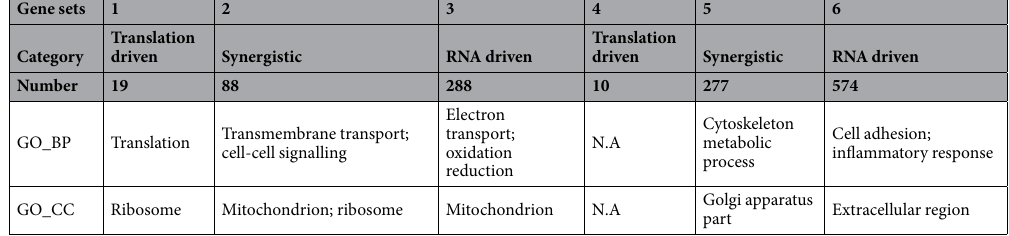
Table 3. Classification of genes with differential total translation between BAT vs WAT and their associated